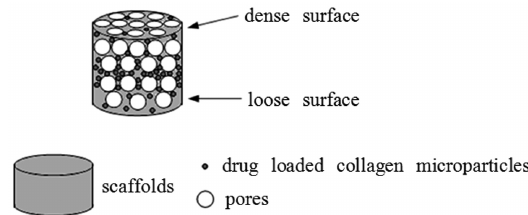
Figure 1. Illustration showing gradient distribution of drug loaded collagen microparticles in HCP scaffolds.